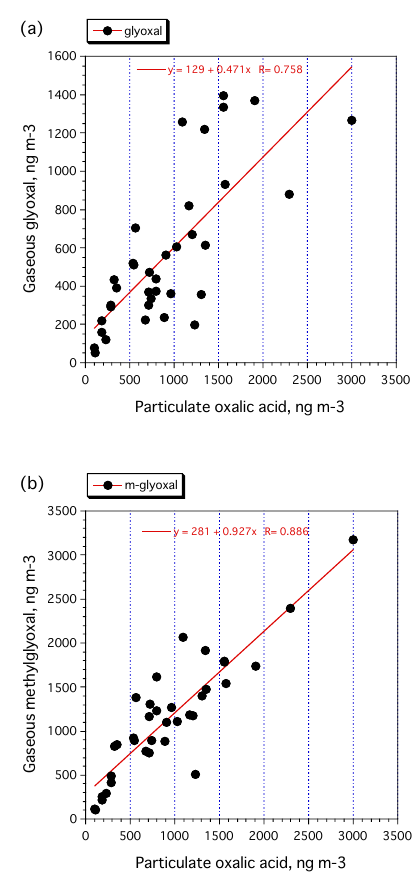
Fig. 11. Correlation plots for (a) gaseous phase glyoxal and particu- late oxalic acid and (b) gaseous phase methylglyoxal and particulate oxalic acid in the atmosphere of Mt. Tai. The data of oxalic acid in aerosols are from Kawamura et al.